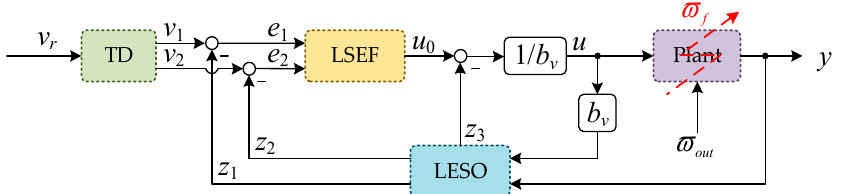
Figure 3. Control schematic of LADRC.